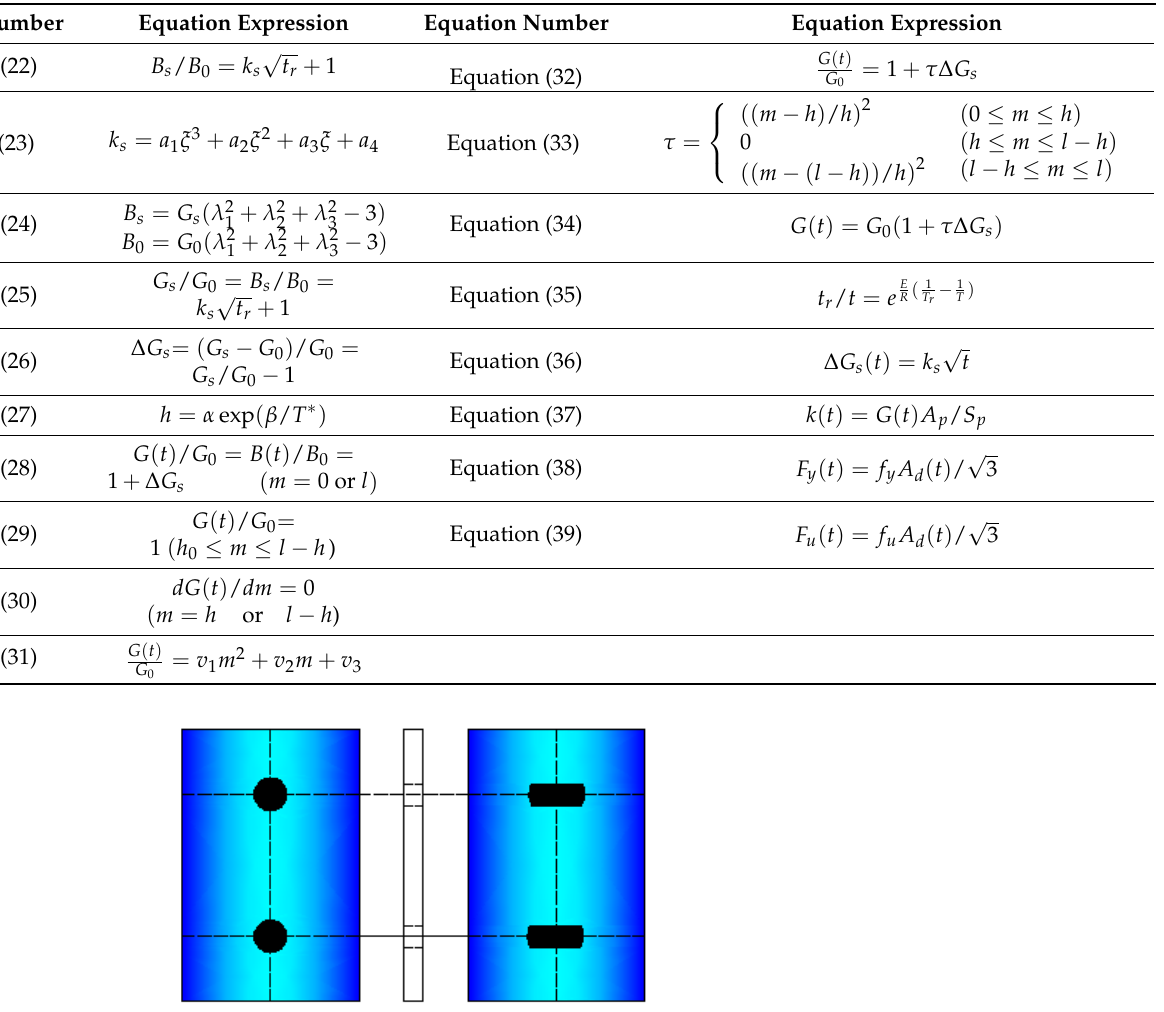
Table 4. Equation list for Section 3.